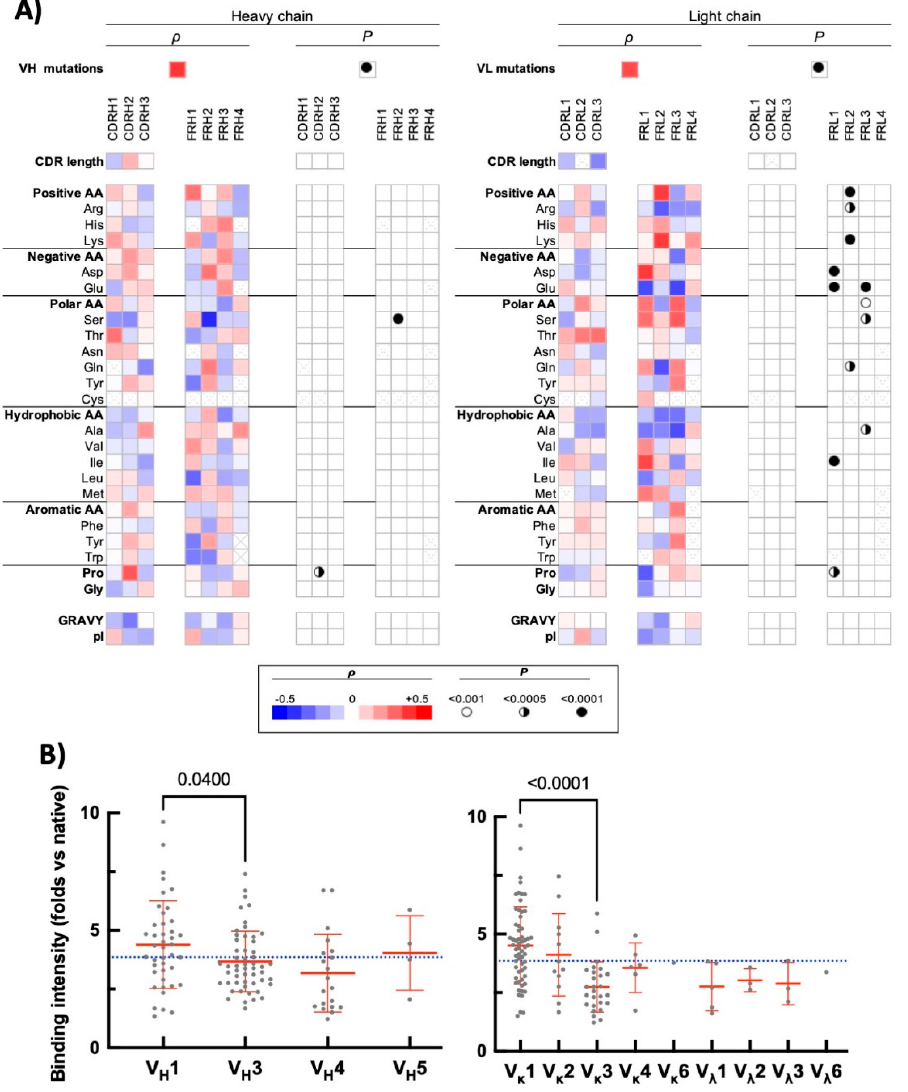
Figure 2. Correlation of sequence features of the variable domains of therapeutic Abs with induced polyreactivity by ferrous ions. ( A ) Heat maps depict the results from Spearman correlation analyses of the average intensity of increase in the binding of the therapeutic Abs to unrelated proteins after exposure to Fe 2+ ions (shown on Figure 1C) with the sequence characteristics of V H ( left panels) and V L ( right panels). Following sequence characteristics were used in correlation analyses: number of somatic mutations in V genes; number of particular amino acids, or types of amino acid residues in CDR and framework regions; overall hydrophobicity (GRAVY index) and values of isoelectric points of V domains (pI). The red colour in the heat maps indicates the positive value of the correlation coefficient ( ρ ), the blue—negative. The intensity of colours signifies the difference of ρ from 0. The summary of statistical significance ( p values) is shown on the right of each heat map. The symbol “ × ” indicates that the corresponding amino acid residue is absent in the studied sequence. ( B ) Frequency distribution of usage of V genes encoding heavy ( left panel) and light ( right panel) V domains as a function of average fold increase in the antigen-binding intensity of Abs gained following exposure to ferrous ions. Antigen reactivity of each Ab is presented as a single grey circle. Rituximab and Trastuzumab have VH and VL genes corresponding to mouse IGHV1-12*01 and IGLV1-40*01 as well as human IGHV3-66*01 and IGKV1-39*01, respectively. In our study, we represented the genes of the chimeric Ab Rituximab as the closest human analogues, i.e., IGHV1-46*01 and IGKV1-39*01. Statistical analyses were performed by using Mann–Whitney nonparametric